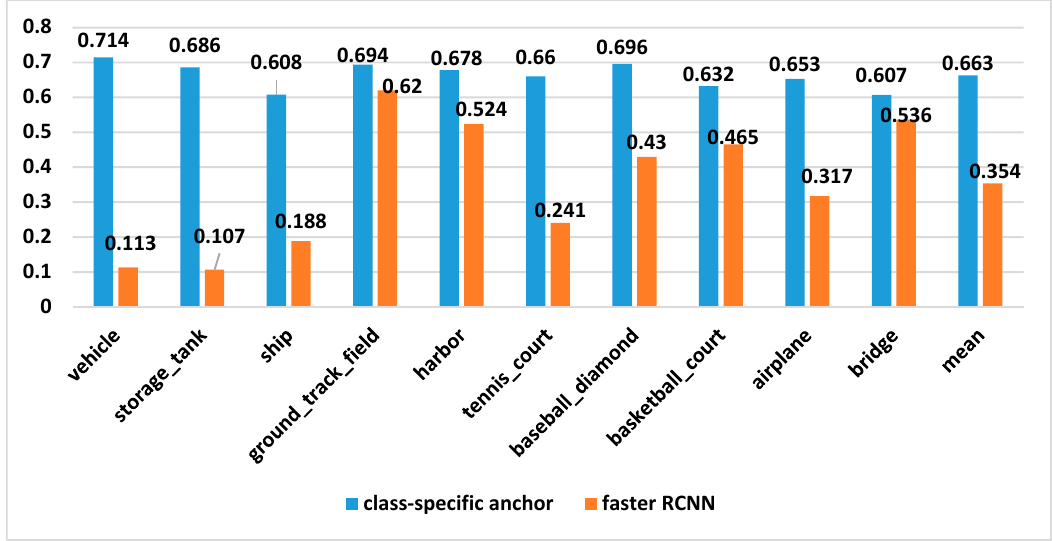
Figure 12. The Average Intersection-over-union of the class-specific anchors and Faster RCNN with the length-width ratios of 1:1, 1:2, 2:1 and scales of 128, 256, 512 with the true bounding boxes for each category.